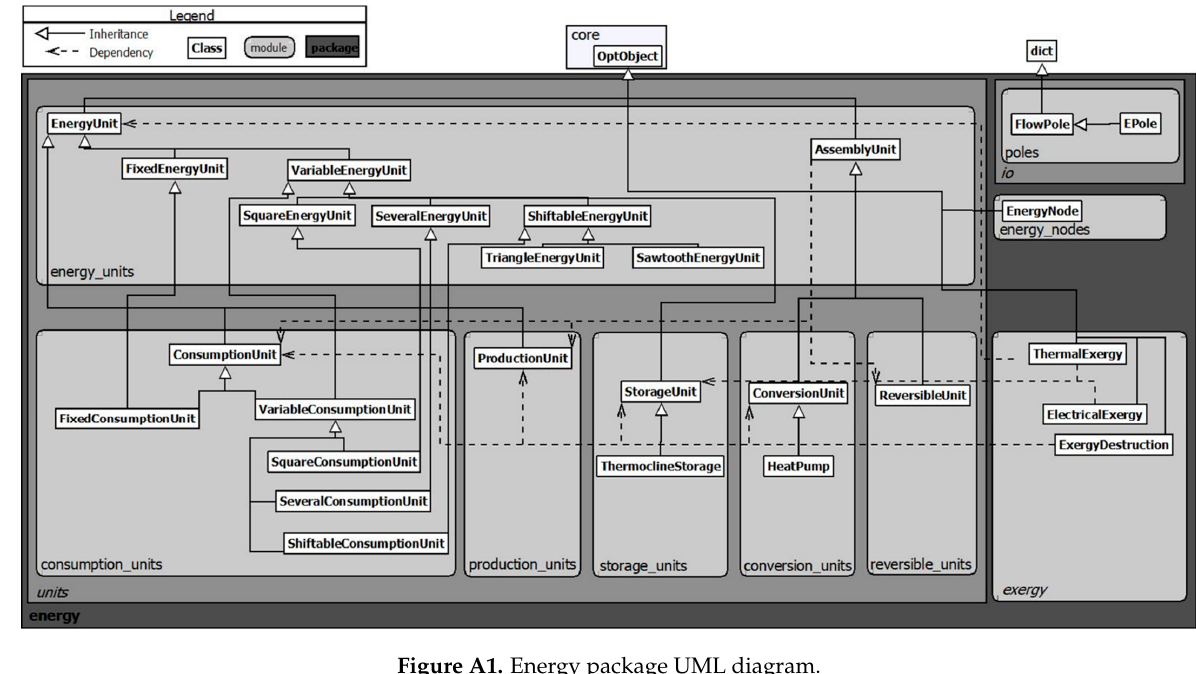
Figure A1. Energy package UML diagram.